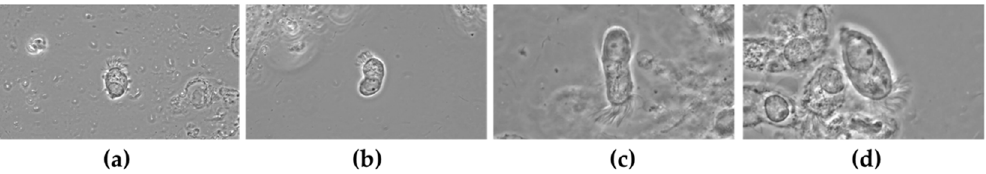
Figure 1. Example of different background noise levels from our dataset ( a , b ) level 1; ( c ) level 2; ( d ) refers to level 3.